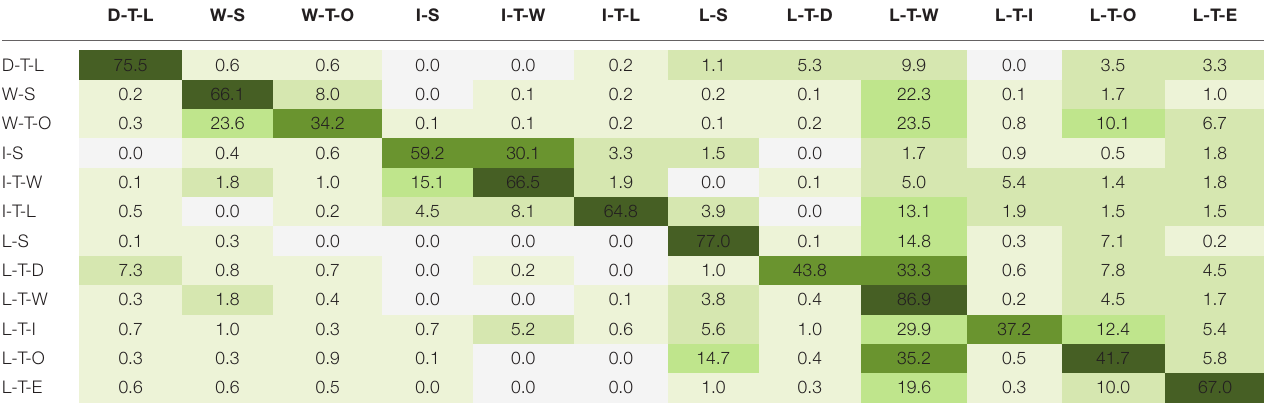
The columns and rows are the predicted and labeled classes,